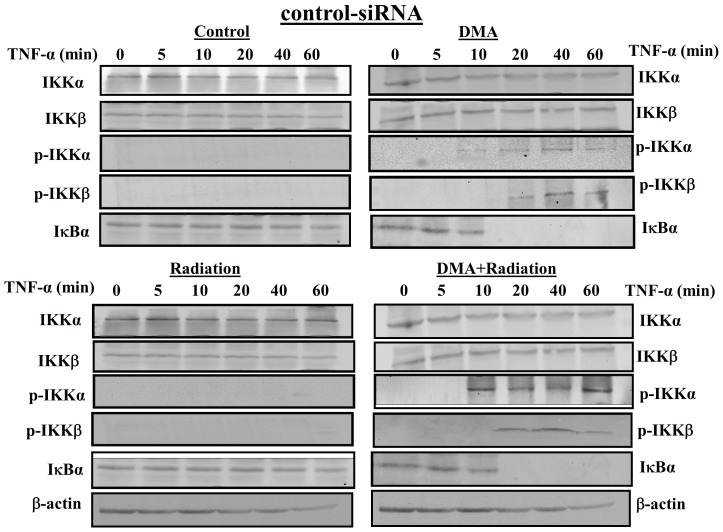
Effect of transfection with control-siRNA on the phosphorylation of IKKα and IKKβ.U87, human glioma cells were transiently transfected with control-siRNA. Cells were induced with 10 ng/ml TNF-α for 0,5,10,20,40,60 min and treated with DMA (50 µM) and/or irradiated at 8.5 Gy. Phosphorylation of IKKα, IKKβ was observed in DMA treated cells, alone or in combination with IR.